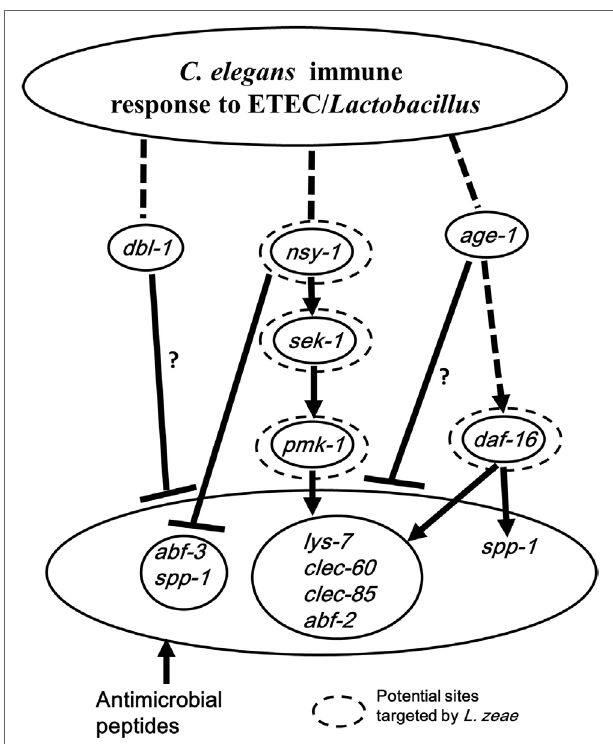
FigUre 6 | Schematic diagram speculating the immunomodulatory mechanism by Lactobacillus zeae . Pretreatment with L. zeae LB1 altered the production of antimicrobial peptides through the p38 mitogen- activated protein kinase (MAPK) and DAF/IGF pathways of cell signaling, therefore, changed the resistance of Caenorhabditis elegans to Enterotoxigenic Escherichia coli (ETEC) infection. The hypothesis was based on the data of both life-span assays and gene expression of various C. elegans mutants either pretreated or not treated with L. zeae LB1 before the ETEC infection. While dashed lines represent the cascades described in previous literatures, solid lines indicate the effects observed in the present study. ▾ , Upregulation; ┴ , downregulation. Dashed circle: potential functional sites in the cell signaling targeted by L. zeae LB1. ?, Indicating that the regulation could be direct or indirect. More specifically, the downregulation in the production of antimicrobial peptides could be controlled by dbl-1 or age-1 directly or through pmk-1 and sek-1 in the p38-MAPK pathway in the wild-type nematode ( Figures 5c,D